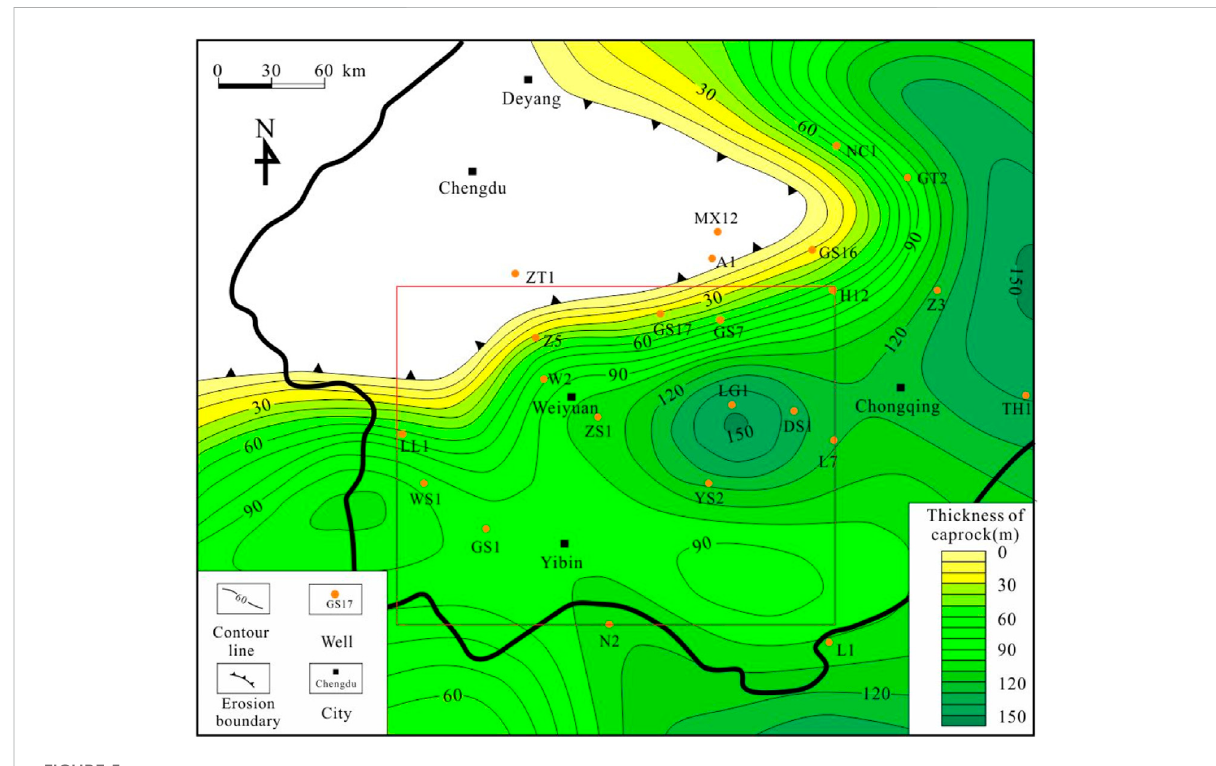
FIGURE 5 The thickness map of the direct caprock of Xixiangchi